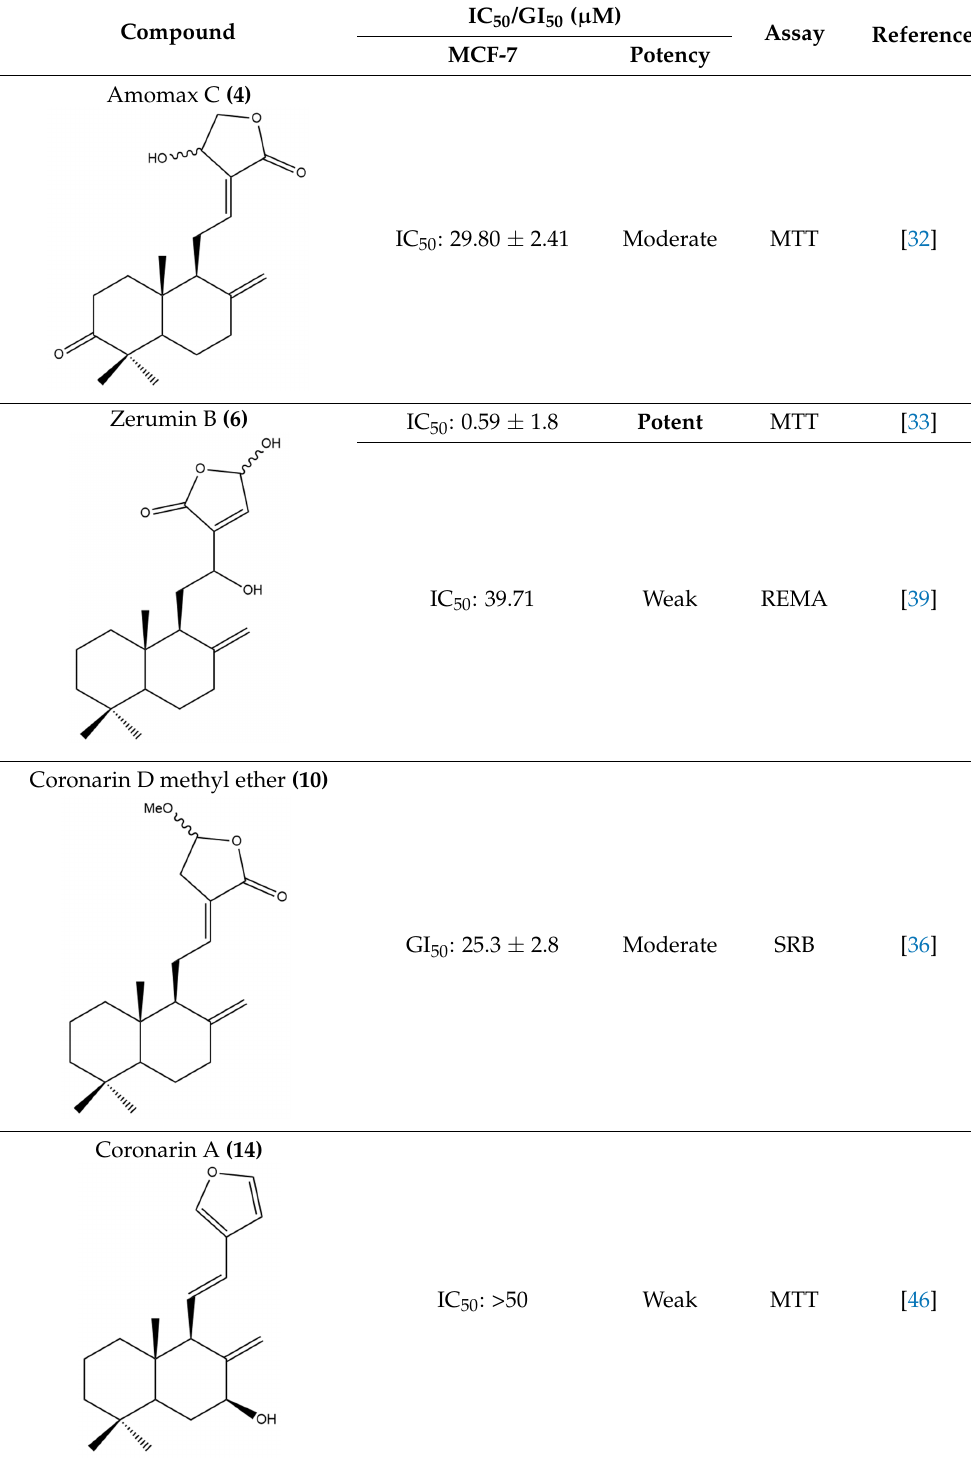
Table 4. Cytotoxic activities of labdane-type diterpenes from the Zingiberaceae against MCF-7 breast cancer cell line. Compound